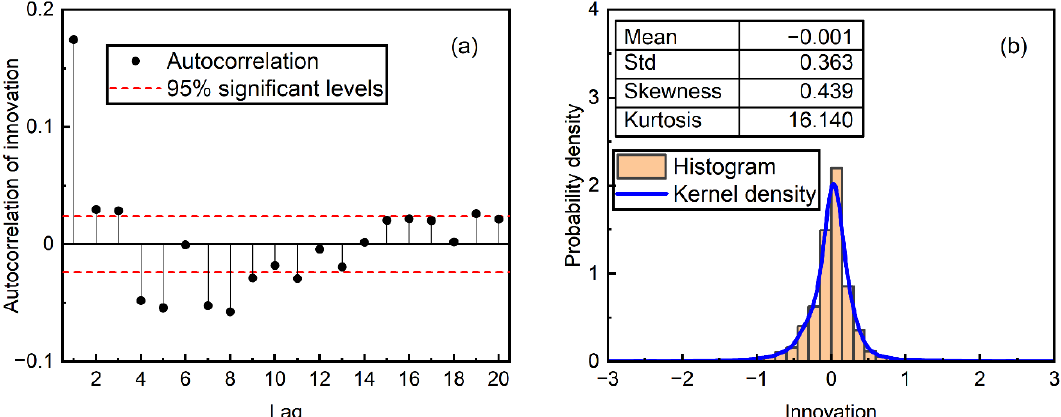
Figure 8. Statistics for the innovation of the KA scenario: ( a ) autocorrelation (black dots) for different lags with 95% significance levels (red dash line); ( b ) histogram and kernel estimate of the probability density function of the innovation. The kernel density is estimated using Equation (8) with an optimal bandwidth b = 0.08.